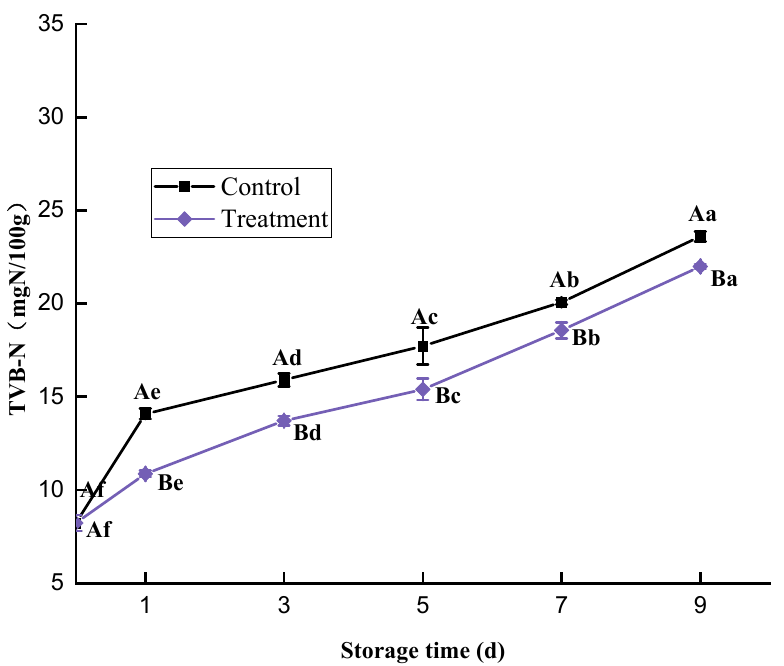
Figure 7. Changes in the TVB-N values of Trachinotus ovatus during refrigerator storage. Within the same group, different lowercase superscripts indicate significant differences ( p < 0.05). Among different groups, different capital letter superscripts indicate significant differences ( p < 0.05).